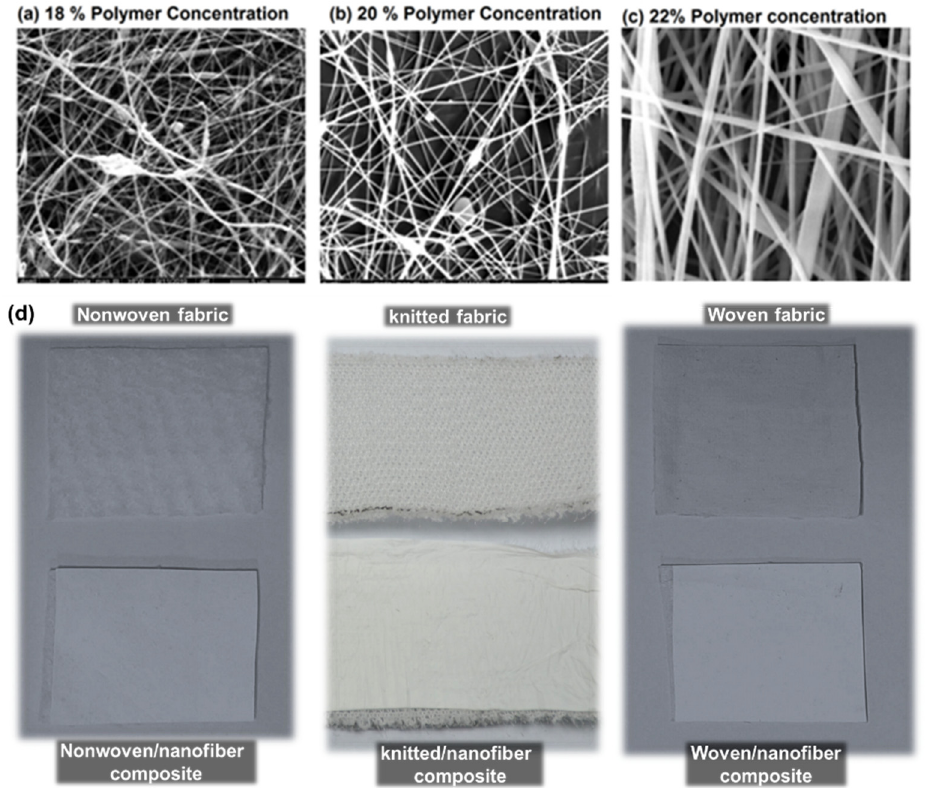
Figure 2. ( a – c ) SEM images of nanofibers diameter at different concentration levels 18, 20, and 22 w / w % with constant applied voltage 45 kV and constant collecting distance 20 cm; ( d ) actual photographic view of nonwoven, knitted, and woven composite.